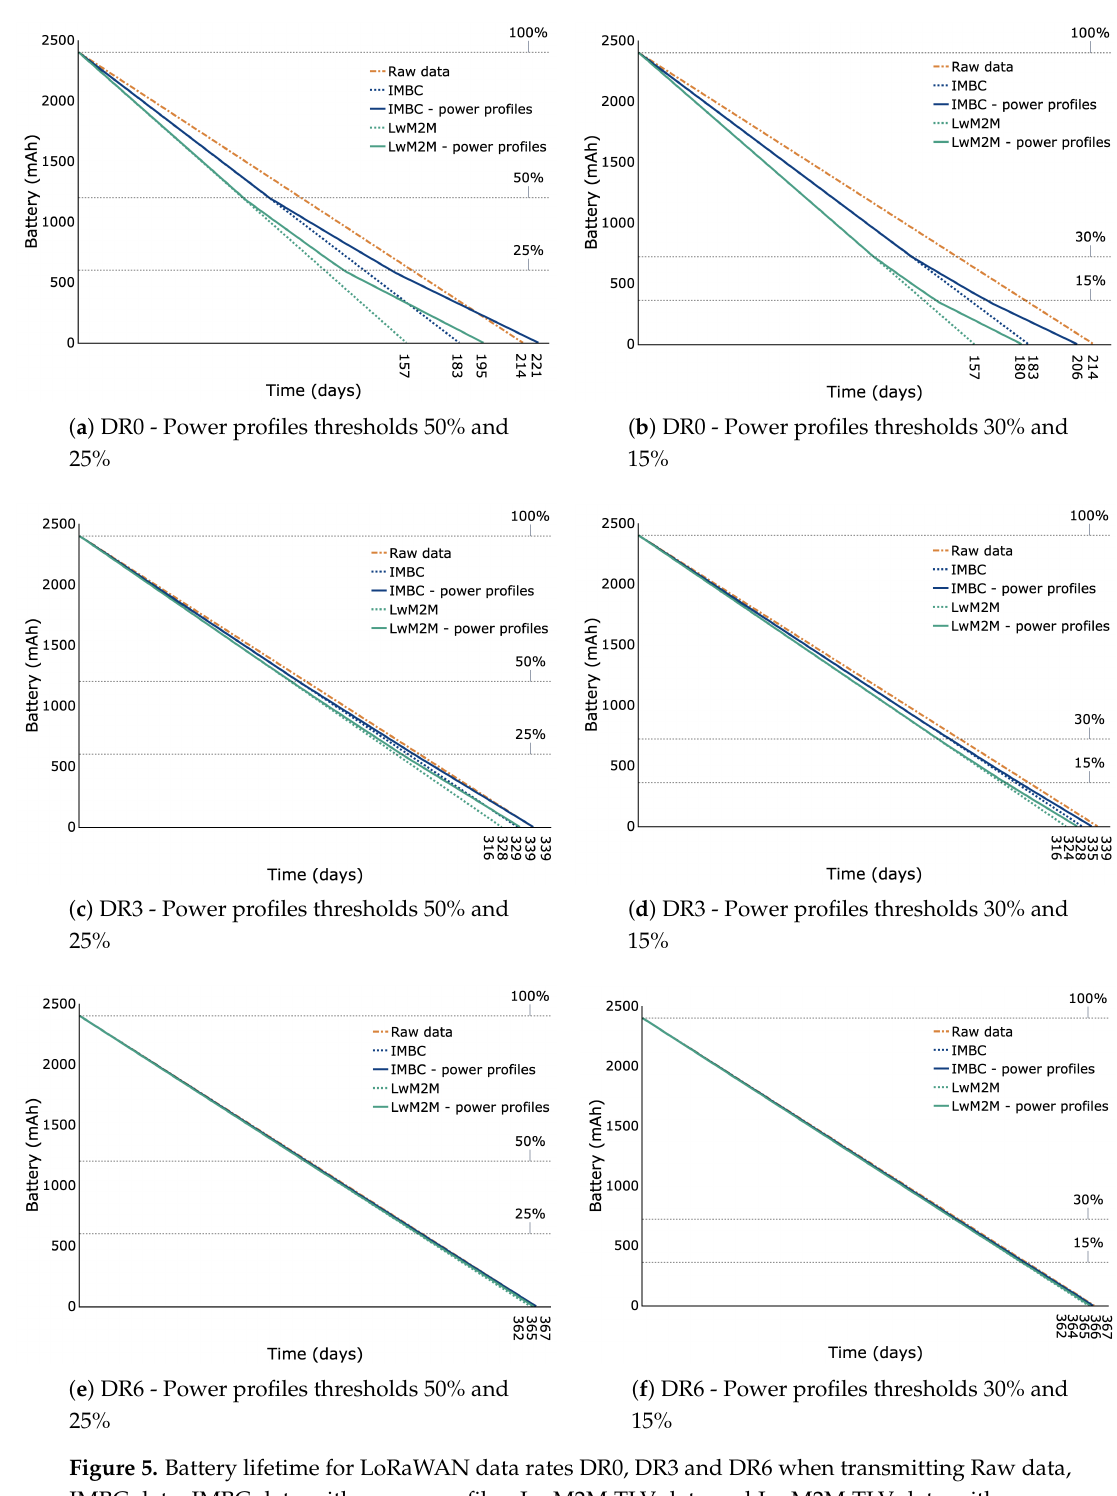
Figure 5. Battery lifetime for LoRaWAN data rates DR0, DR3 and DR6 when transmitting Raw data, IMBC data, IMBC data with power profiles, LwM2M TLV data and LwM2M TLV data with power profiles. The orange coloured lines correspond to Raw data, the blue coloured lines correspond to IMBC data and the green coloured lines correspond to LwM2M